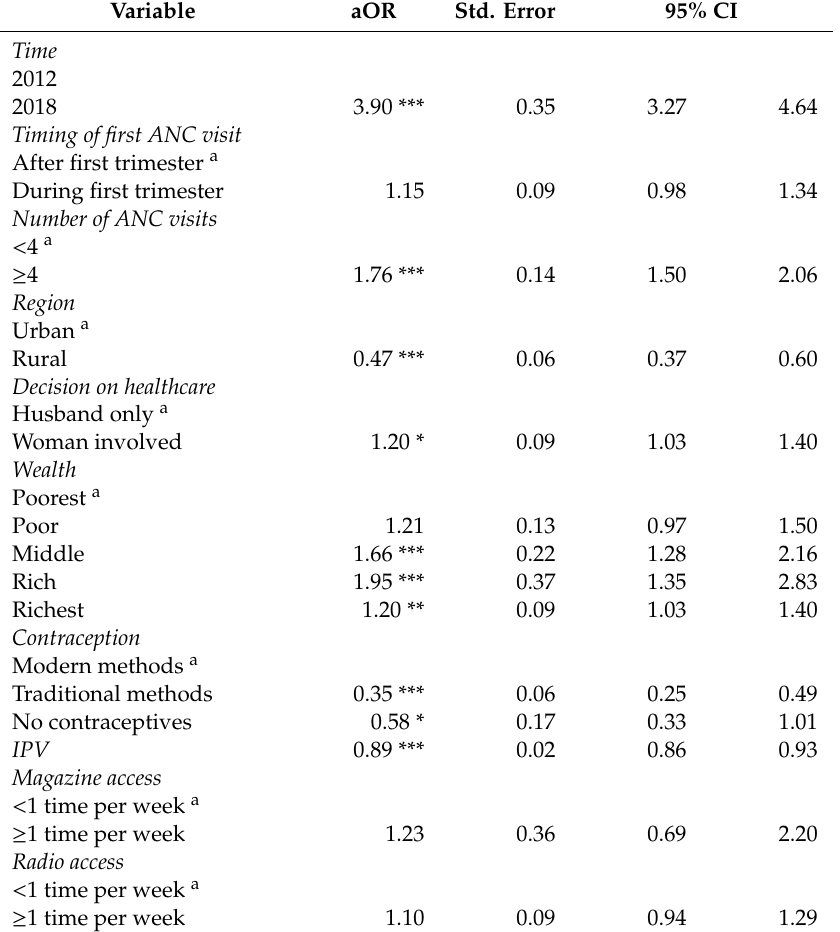
Table 2. Results from adjusted logistic regression